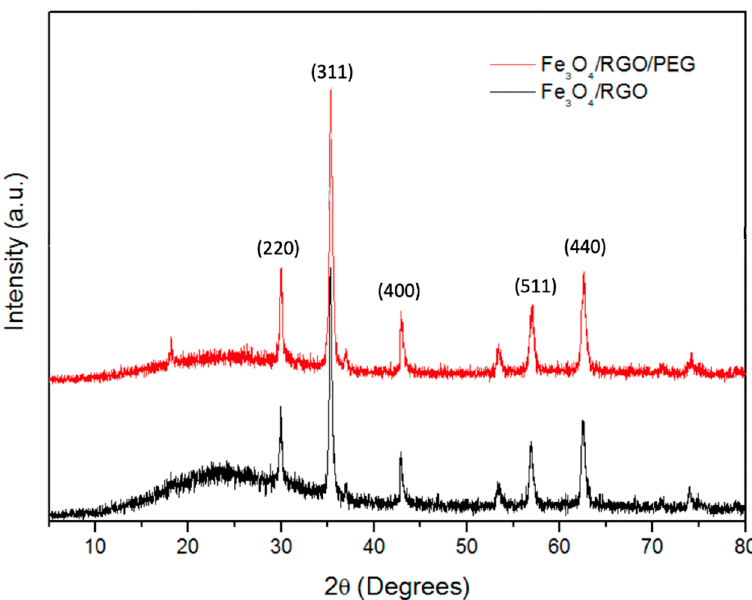
Figure 1. Comparative XRD analysis for Fe 3 O 4 nanocomposites containing RGO and PEG.